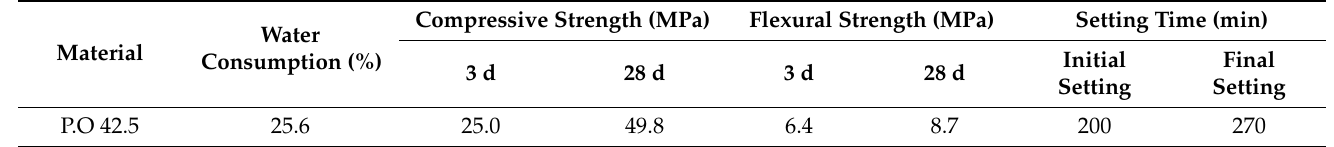
Table 1. Physical and mechanical properties of cement.